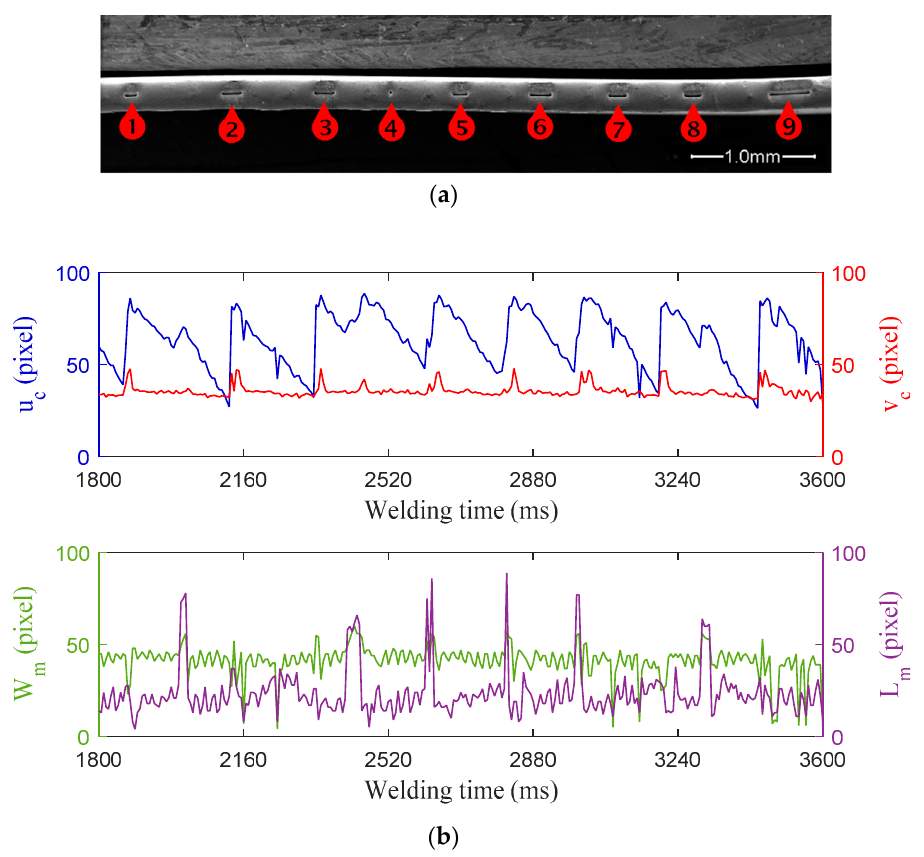
Figure 9. Experiment results with lack of fusion caused by excessive weld joint gap: ( a ) Top-view of the edge weld profile observed under SEM with 46× magnification; and, ( b ) Characteristic parameters of weld pool monitored during MPAW.